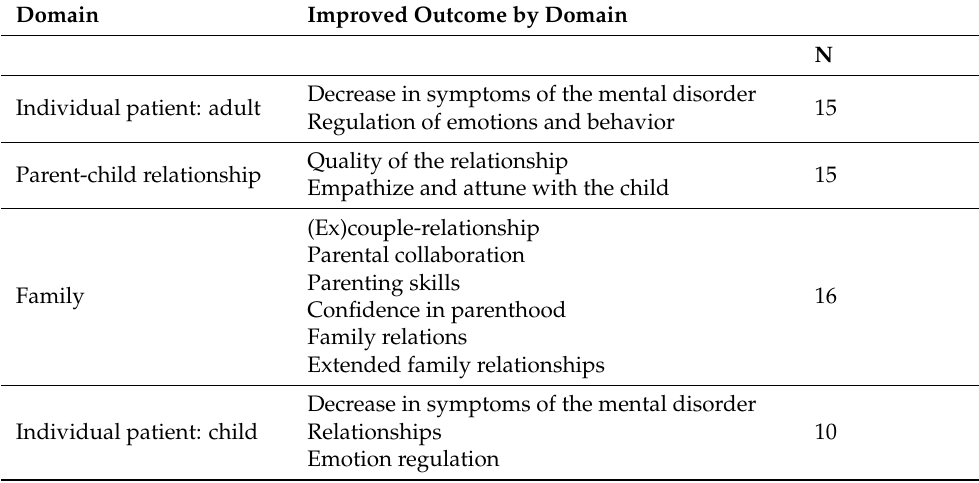
Table 3. Improved outcomes in different domains perceived by